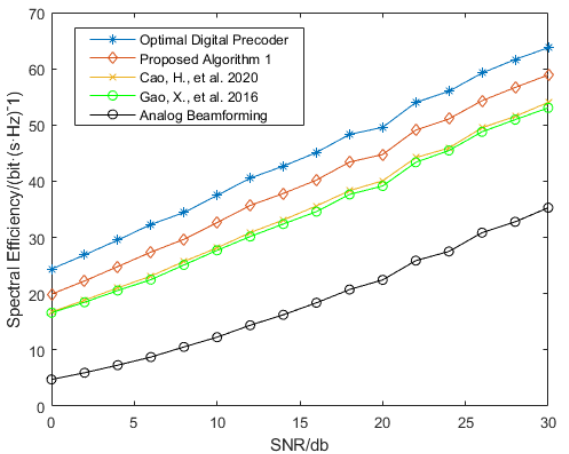
Figure 3. At high SNR, spectral efficiency of different algorithms ( N t × N r = 128 × 16, N RF = 8, N s = 8). [18,21]